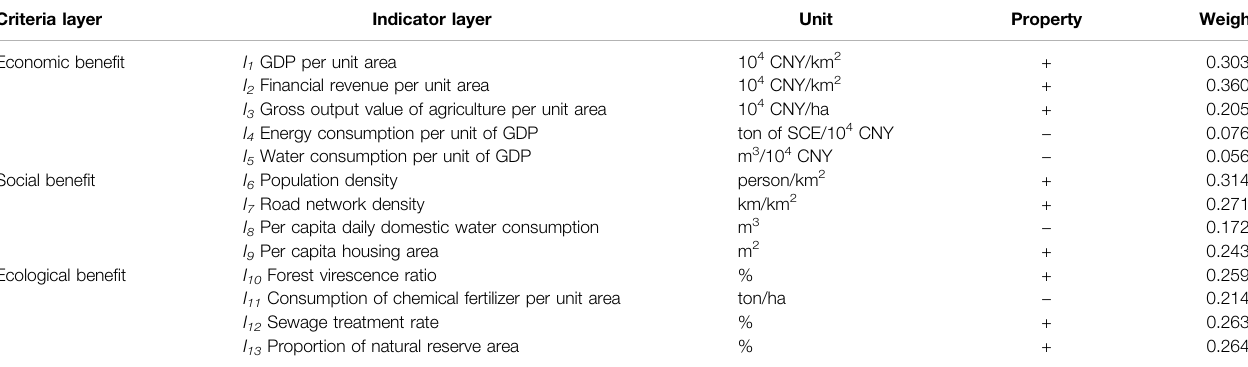
TABLE 1 | Index system for assessing NRUBs. Criteria